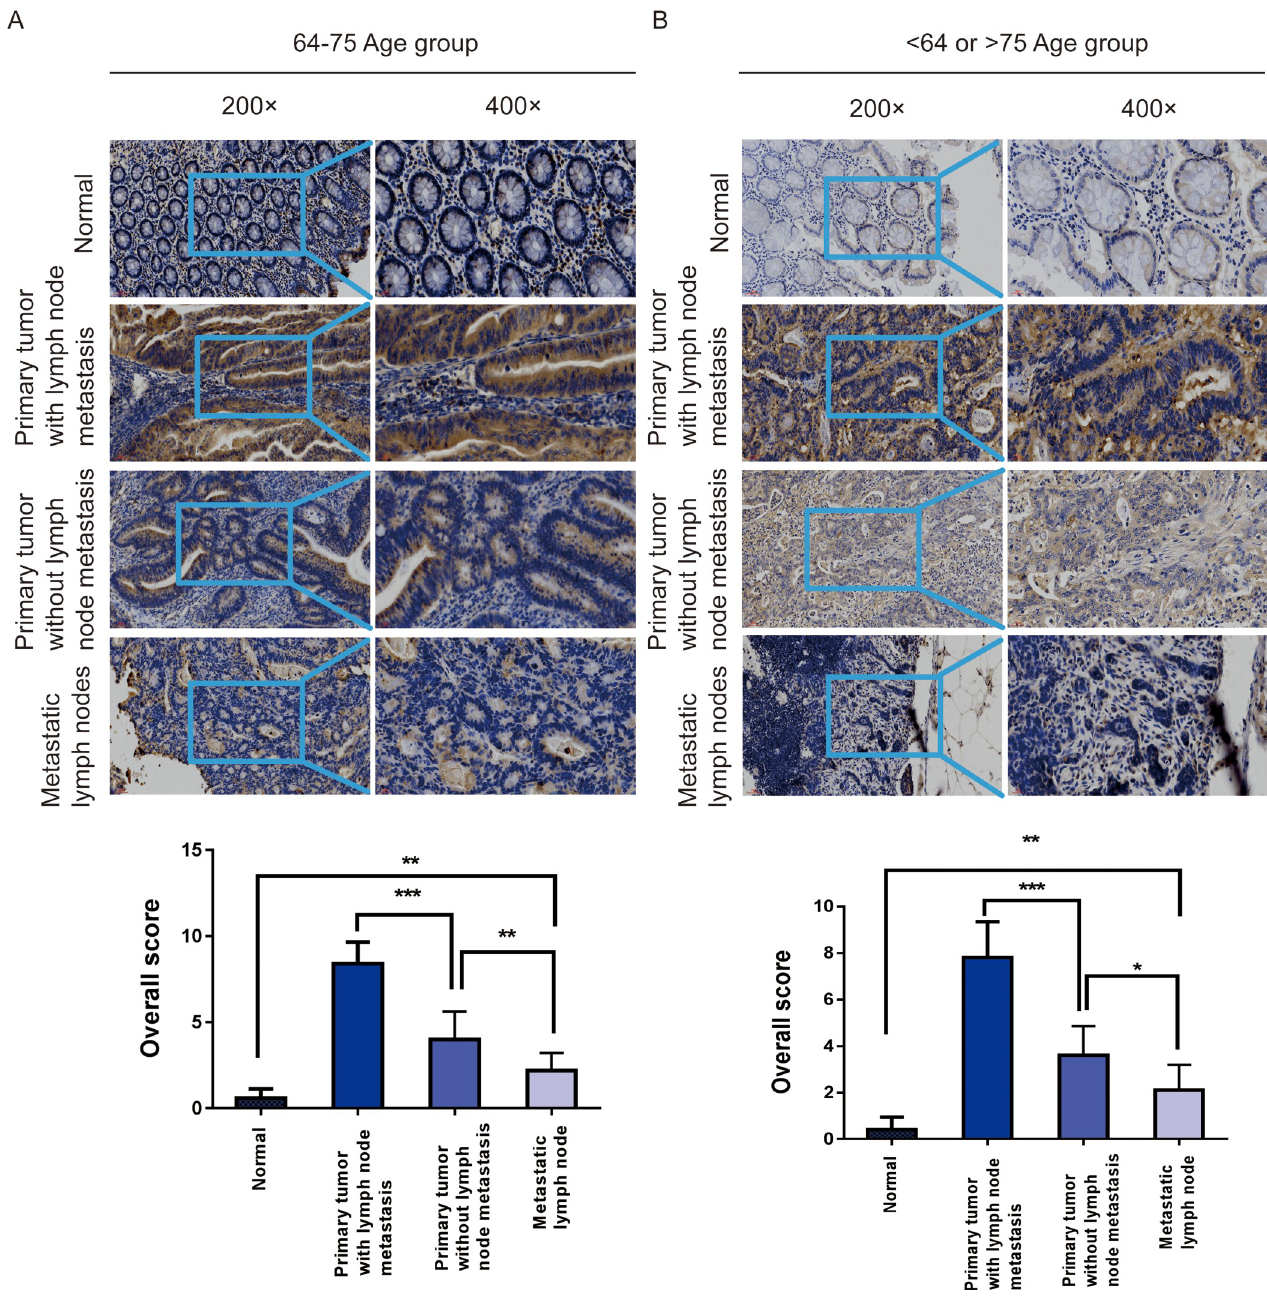
Fig 4. MACC1 protein expression levels in colorectal cancer tissues with and without lymph node metastasis. (A) Immunohistochemical method was used to detect the expression level of MACC1 protein in normal control tissues, colorectal cancer tissues from patients with lymph node metastasis, non-metastatic colorectal cancer tissues, and metastatic lymph node tissues in patients aged 64–75 years. (B) Immunohistochemical method was used to detect the expression level of MACC1 protein in normal control tissues, colorectal cancer tissues from patients with lymph node metastasis, non-metastatic colorectal cancer tissues, and metastatic lymph node tissues in patients younger than 64 years and older than 75 years. � p < 0.05; �� p < 0.01; ��� p < 0.001. expression and lymphatic metastasis in the middle age group. Threshold and saturation effects were then found at the turning point when MACC1 levels reached 1.4. The probability of metastasis slightly increased with the MACC1 level lower than turning point 1.4. While the